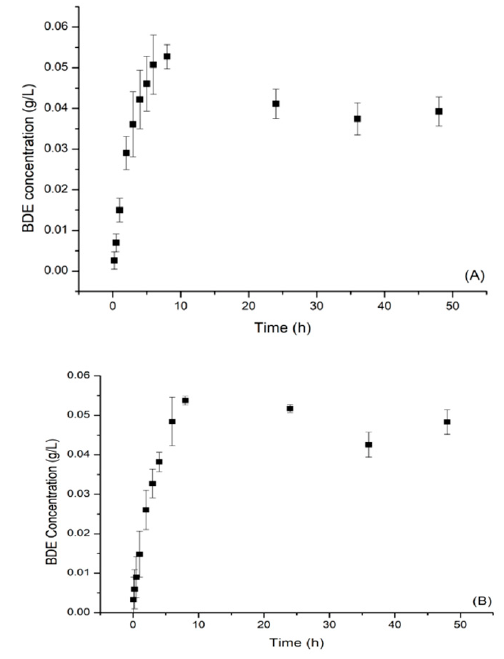
Figure 8. B. dracunculifolia extract release kinetic curves at pH 2.6 ( A ) and pH 7.7 ( B ).